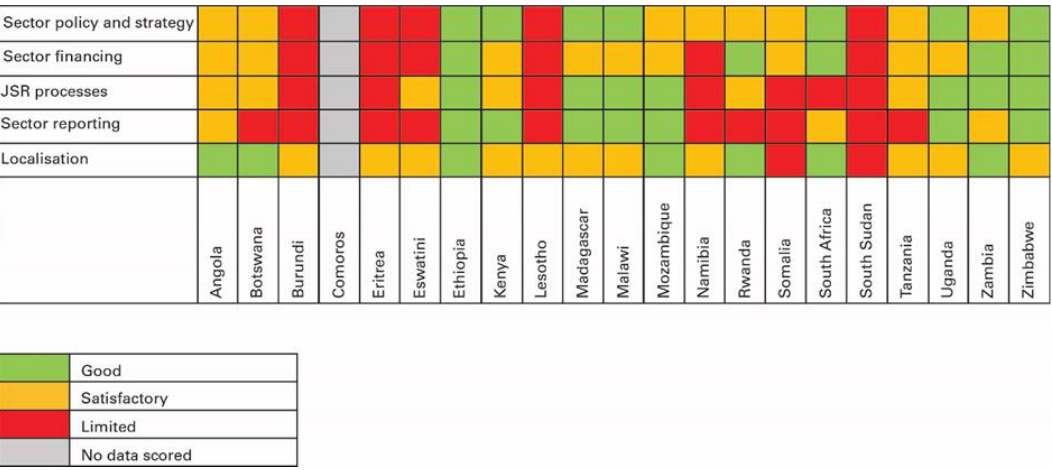
Figure 3. WASH monitoring scoring for ESAR countries’ the enabling environment. Adapted from Harris and Pearce [30]